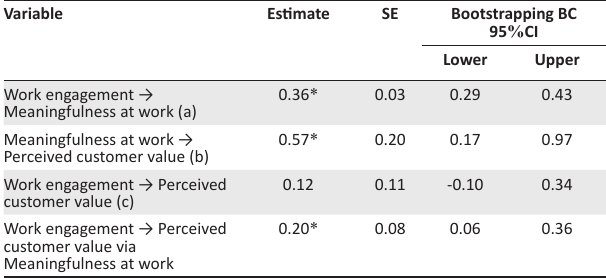
TABLE 2: Standardised regression coefficients: work engagement, meaningfulness at work and perceived customer